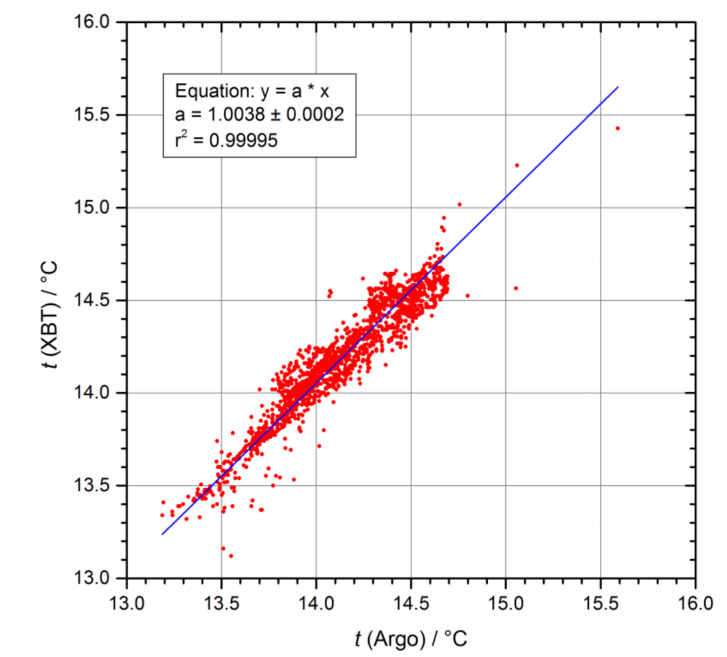
Figure 11. XBT vs. Argo values: linear fit (matched values for d > 100